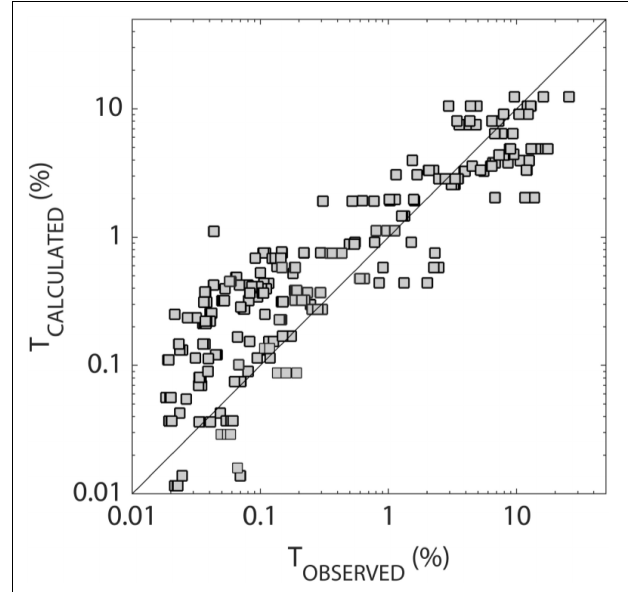
FIGURE 1 | Calculated versus observed transmittance ( T ), based on environmental and optical observations from the Green Edge field operations (two fast ice camps, one drift ice cruise in spring and summer 2015–2016, N = 258; Oziel et al., 2019; Randelhoff et al., 2019). Observed transmittance is the ratio of irradiance under sea ice to that above sea ice, both from radiometers deployed in situ. Calculated transmittance derives from equations 1–4, using observed values of snow and ice thicknesses, air temperature and melt pond coverage, and with input parameters from Table 1